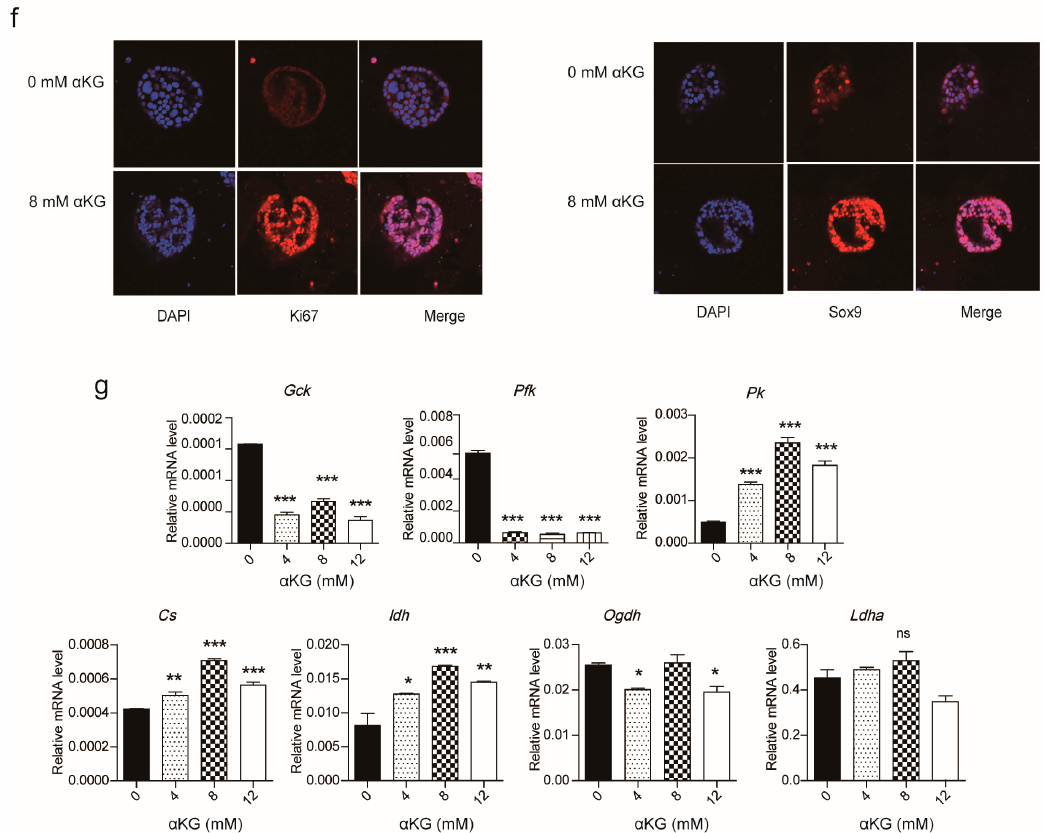
Figure 3. α -ketoglutarate ( α KG) affected the proliferation of pancreatic progenitor-like cells in 3D culture. ( a ) The pancreatic single cells were cultured in a 3D cultured system with α KG at the indicated doses; the progenitor- and proliferation-related mRNAs were detected by Real-time PCR; ( b ) 0 mM and 8 mM α KG was added into the 3D culture system at the culture’s beginning; the colony forming frequency was evaluated via the described method, and ( c ) the colonies were observed under an inverted microscope; ( d ) single cells/well digested from α KG cultured colonies were counted; ( e ) the self-renewal ability in 3D culture with 0 mM α KG and 8 mM α KG; ( f ) the Sox9 and Ki67 levels in the colonies were detected by immunofluorescence under laser scanning confocal microscopy; nuclei were stained with DAPI; ( g ) The mRNA levels of glucose metabolism-related speed limit enzymes of α KG treated colonies were tested by Real-time PCR. The arrows are used to point colonies for easy viewing and identification. Results are shown as mean + SEM and represent three independent experiments. *** p < 0.001 versus 0 mM α KG group; ** p < 0.01 versus 0 mM α KG group; * p < 0.05 versus 0 mM α KG group; ns, no significant difference.